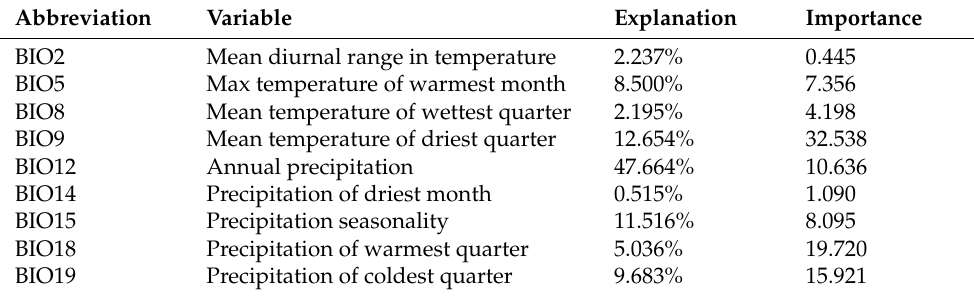
Table 3. Percentage explanation and permutation importance of the bioclimatic